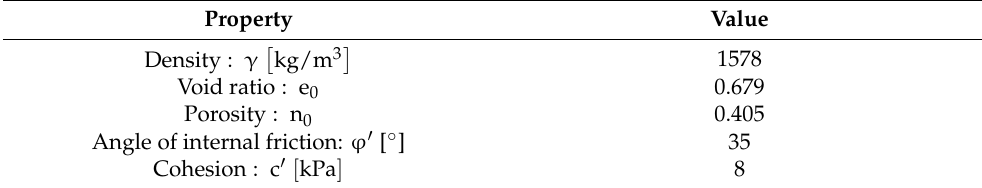
Table 1. Sand properties (Salazar et al. [8]).